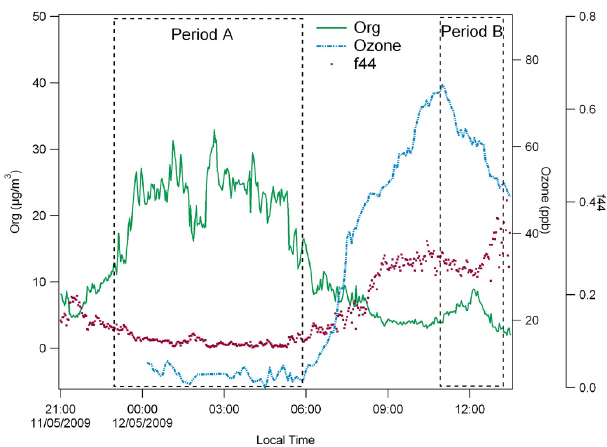
Fig. 9. The organic mass concentration, f 44 and the ozone concen- tration as a function of local time including the burning event and the day after at noon time. Photochemical production of ozone and oxidation lead to higher f 44 values during the day following the